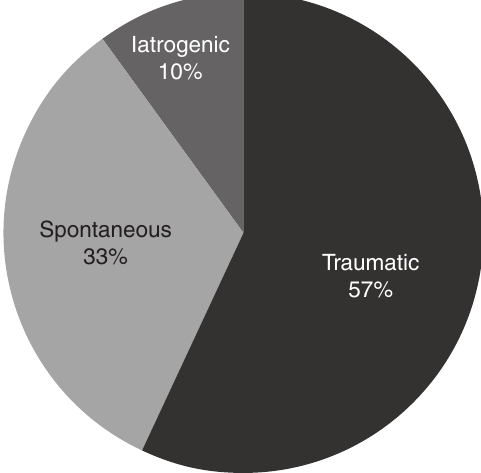
Figure 4 Distribution of etiologic factors of nasal